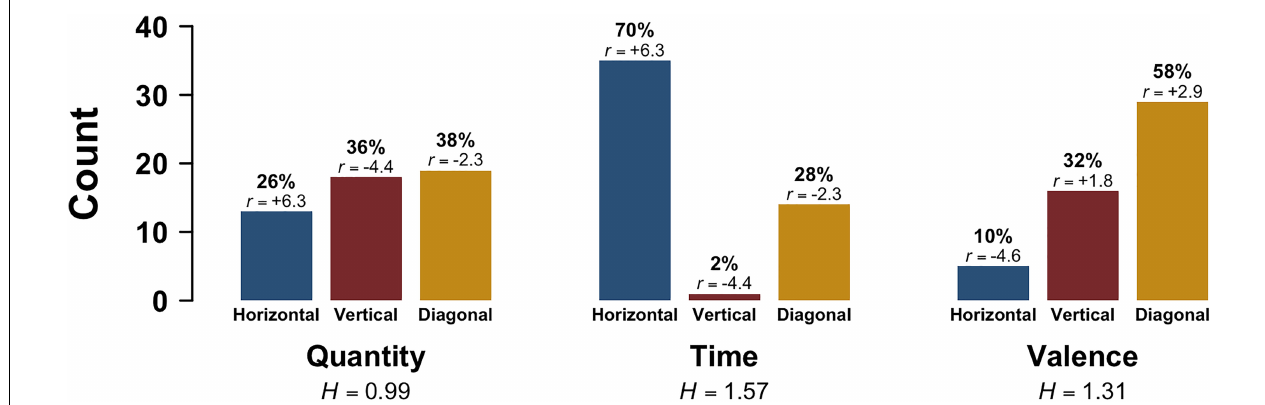
FIGURE 1 | Experiment 1: Dominant Orientation (horizontal, vertical, diagonal) as a function of task; r indicates adjusted standardized Pearson residuals, which are based on the pooled data (participants contribute multiple data points), and H indicates Shannon entropy scores.